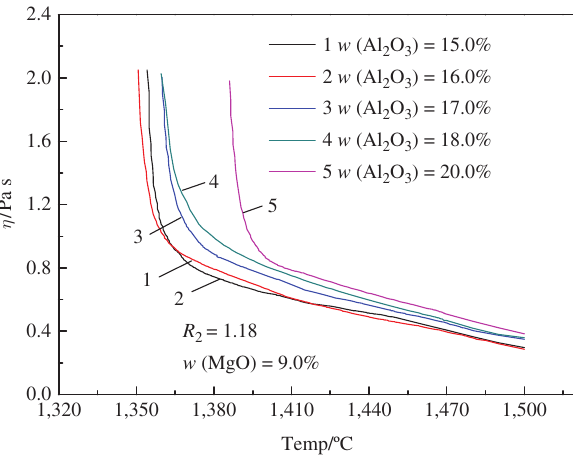
Figure 2: Effect of w (Al 2 O 3 ) on viscosity of slag.